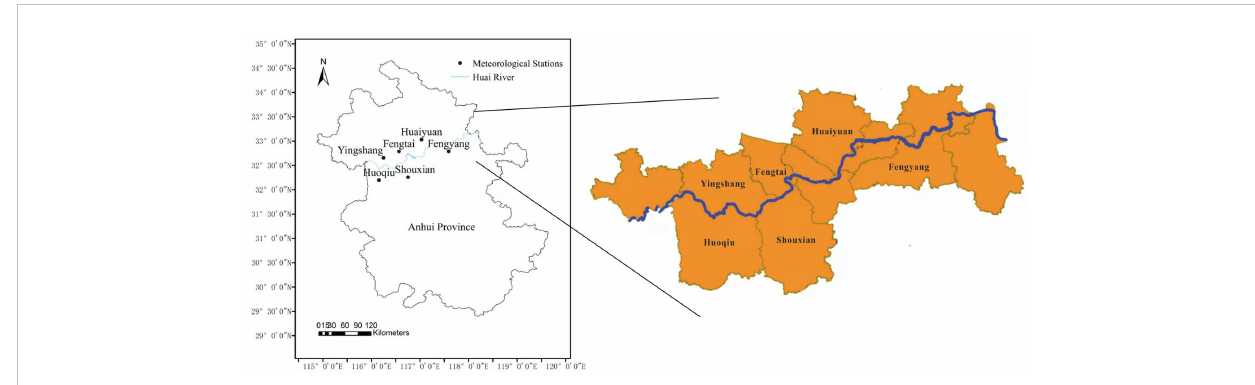
FIGURE 1 Locations of the six meteorological stations i.e. Yingshang, Huoqiu, Fengtai, Shouxian, Huaiyuan, and Fengyang in ‘ Yanhuai ’